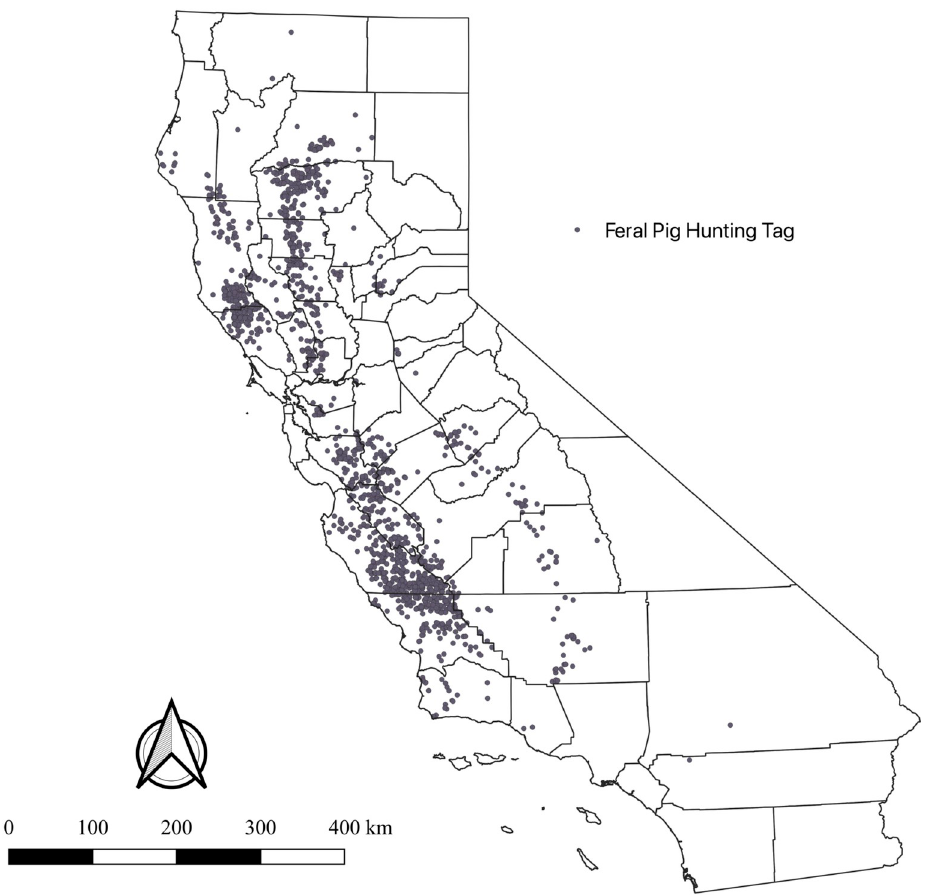
Fig 1. California feral pig hunting tags from 2017. Each point represents a GPS location of a feral pig hunting tag, after removing duplicate locations.